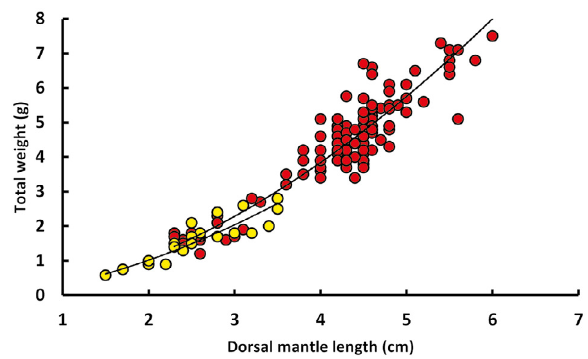
Fig. 2. – Length-weight relationship of Abralia andamanica males (yellow circle) and females (red circle) from the Arabian Sea.